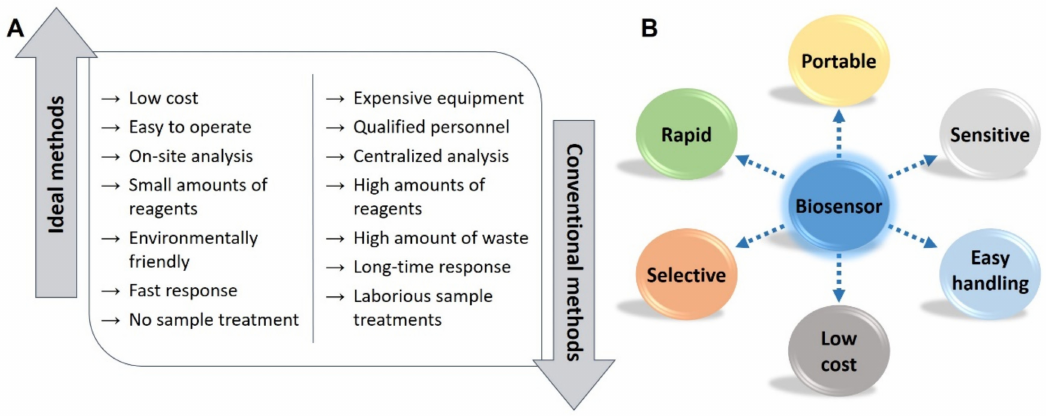
Figure 1. Schematic representation of ( A ) the advantageous features of ideal analytical methods vs. disadvantageous features of conventional ones and ( B ) the advantages of screen-printed based biosensors. The last one adapted from [12] with permission from